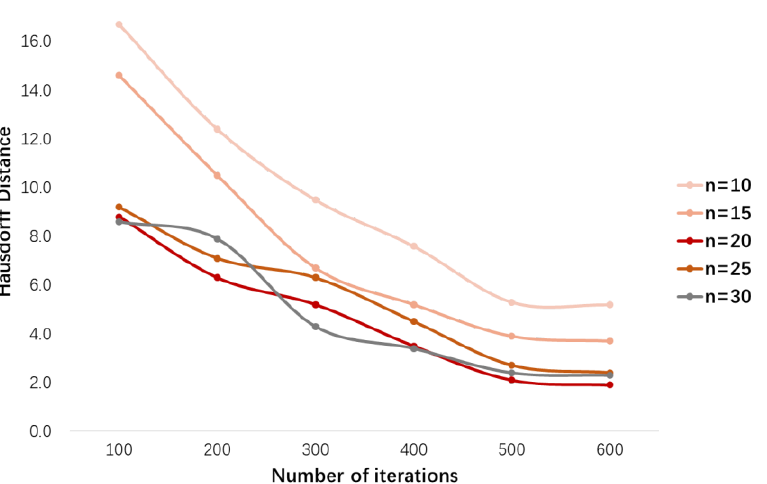
Figure 10. The number of boundary key points n takes different values, and the corresponding HD value decreases curve plots.